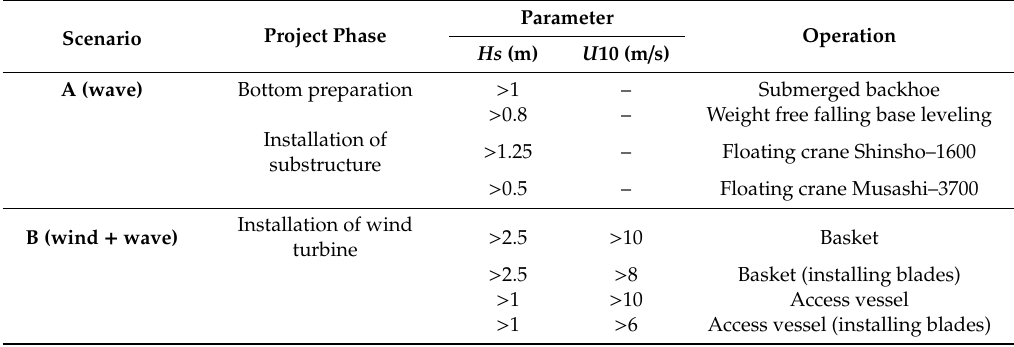
Table 2. Operational limits reported for di ff erent stages of an o ff shore wind project